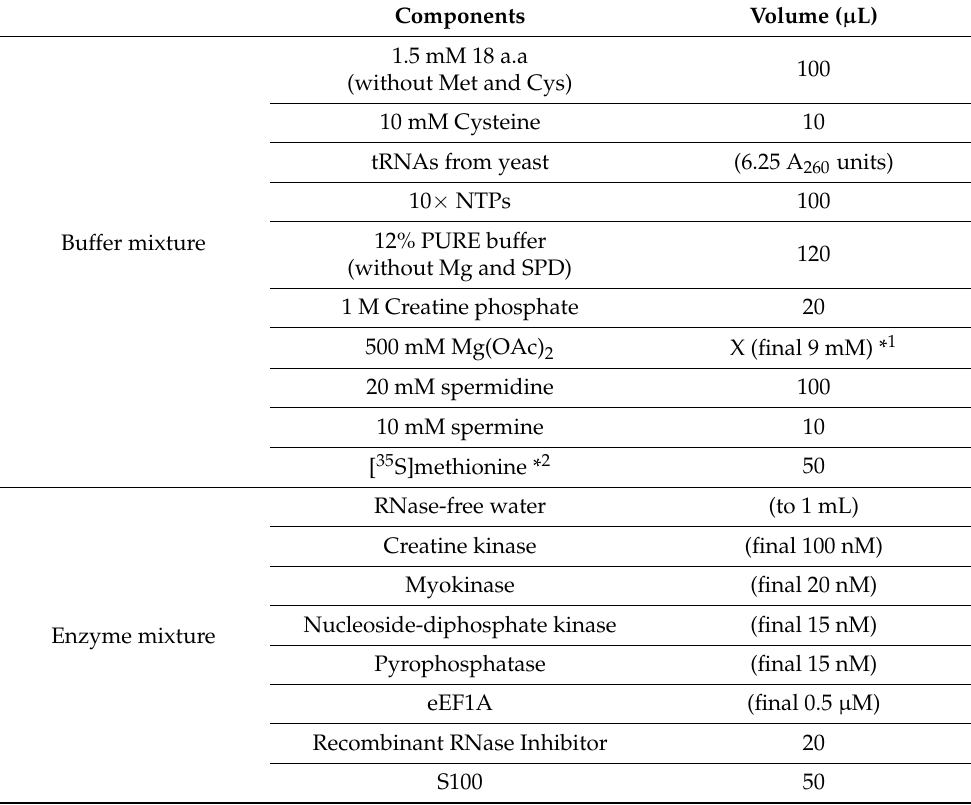
Table 1. Components in the aminoacylation